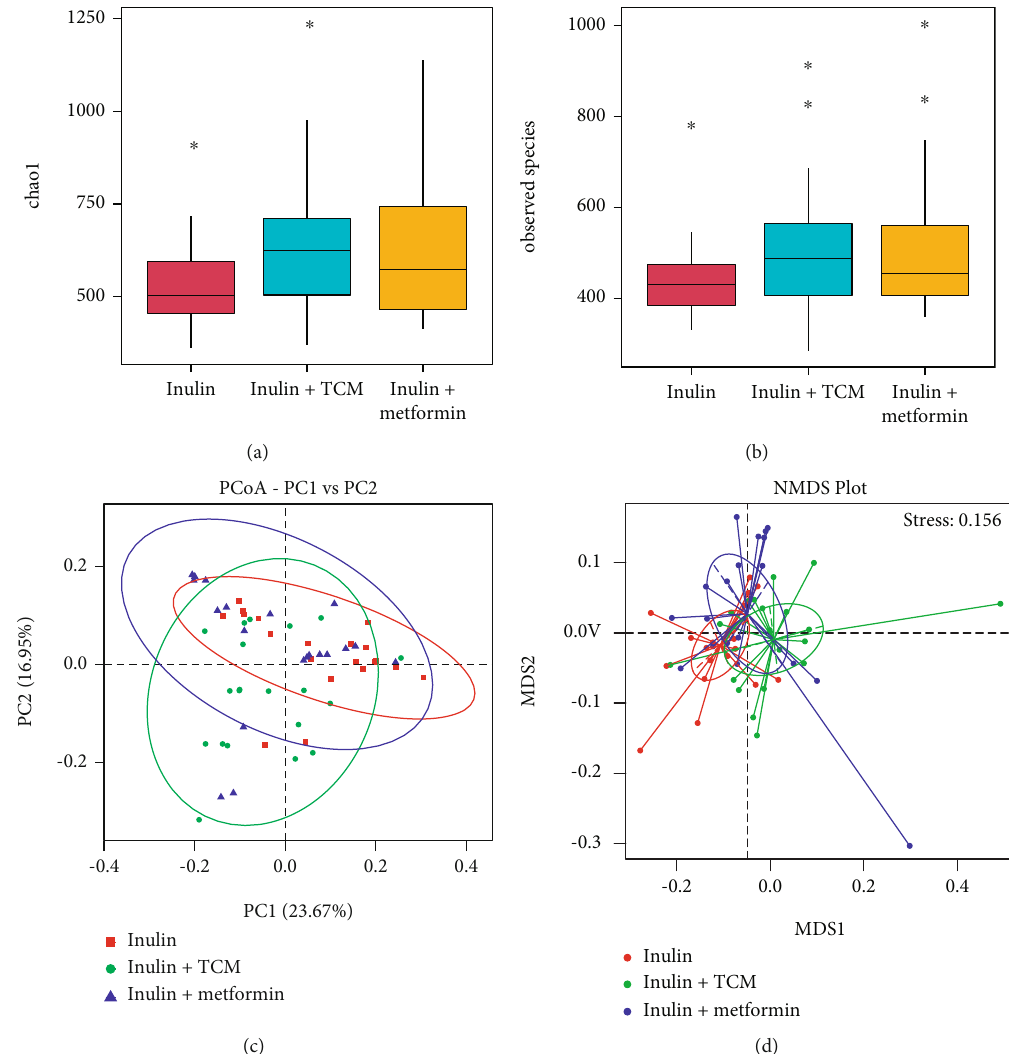
Figure 1: Shifts in enteric bacterial composition after 6 months of intervention. (a, b) Numbers of species and Chao1 diversity indices of intestinal bacteria assessed by 16S rRNA high-throughput sequencing signi fi cant di ff er (Kruskal – Wallis χ 2 test; n = 20 per group). (c, d) PCoA and NMDS analyses of intestinal bacterial composition pro fi les. NMDS: nonmetric multidimensional; PCoA: principal coordinate